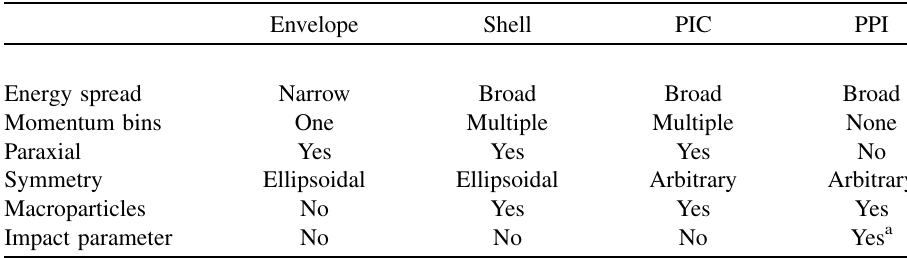
TABLE I. Some properties of four methods (coupled envelope equations, ellipsoidal shells, modified electrostatic particle-in-cell, and point-to-point interaction) used to model electron bunch